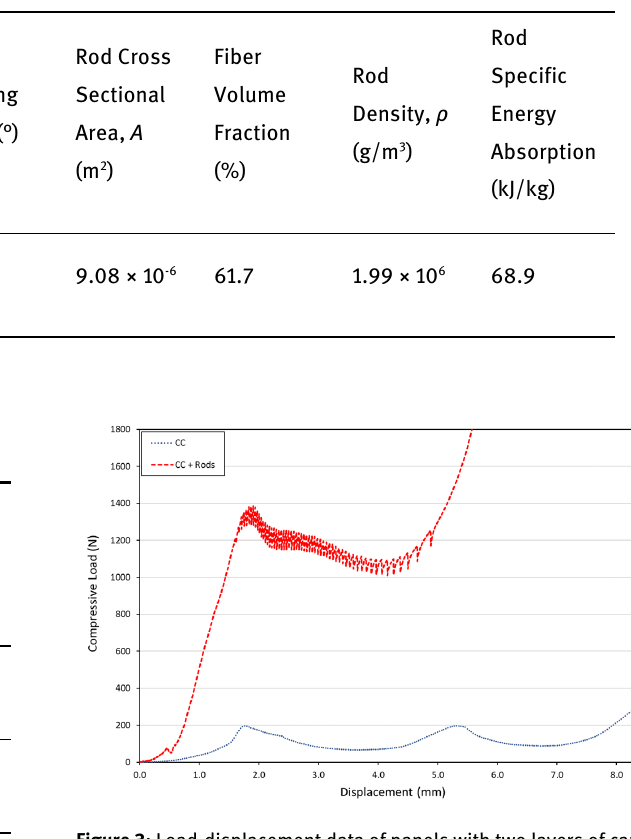
Figure 3: Load-displacement data of panels with two layers of card- board (CC) with and without